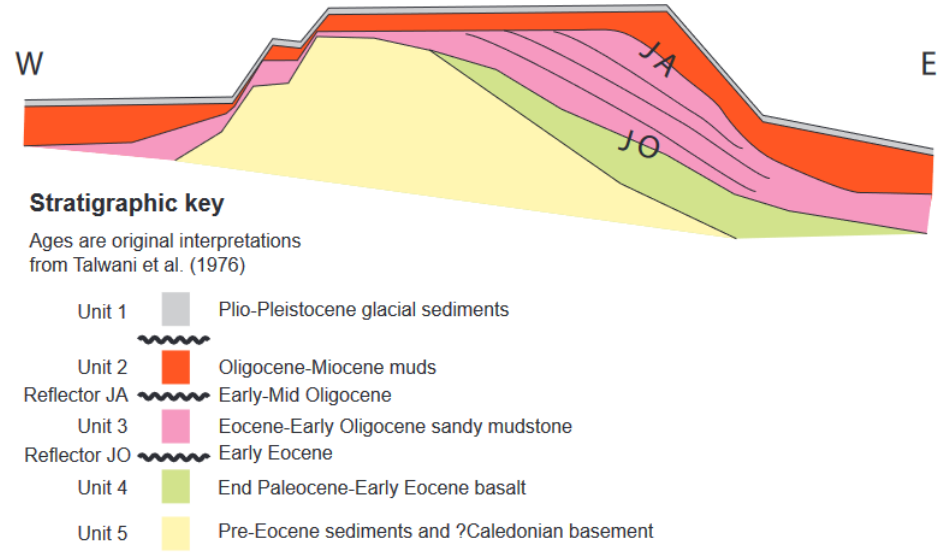
Figure 3. Schematic cross ‐ section of the Jan Mayen Ridge illustrating the geometry of the principal stratigraphic units (after Talwani et al. [15]).